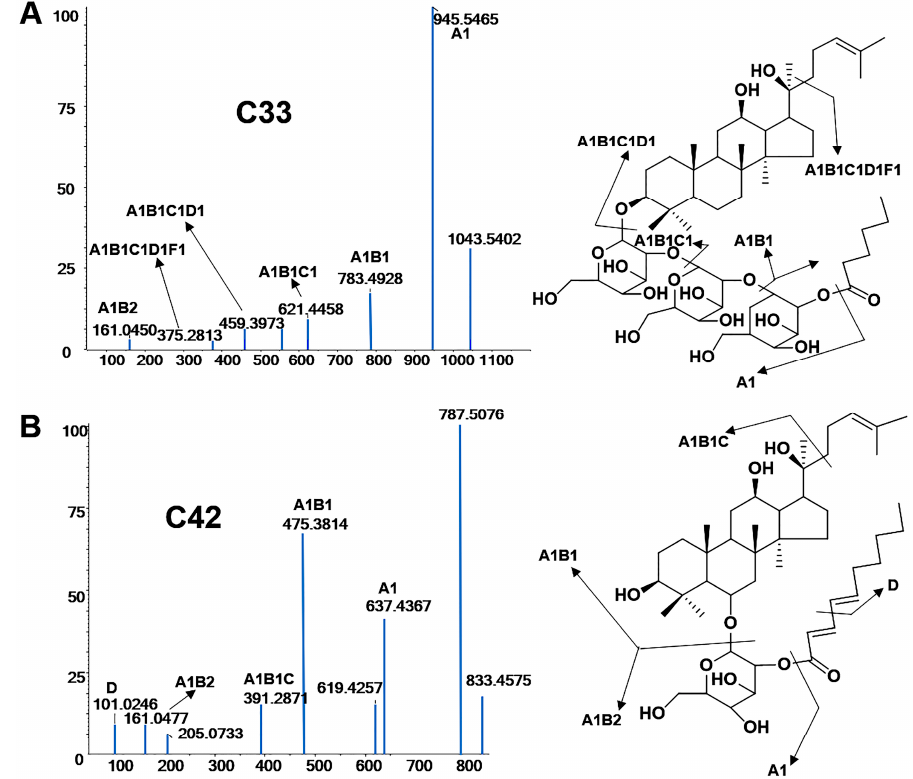
Figure 2. The secondary mass spectra and the fragmentation process: ( A ) C33, ( B ) C42.